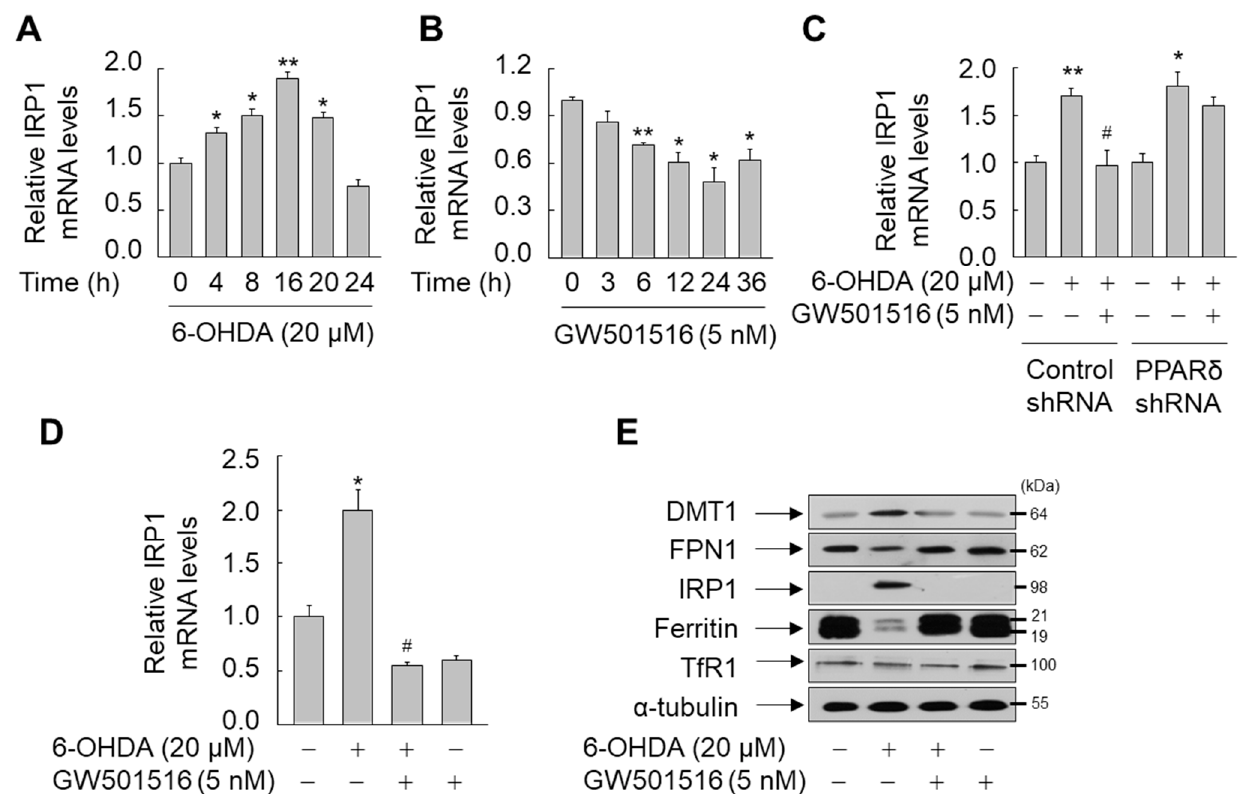
Figure 6. GW501516 PPAR δ activation suppresses 6-OHDA-induced expression of IRP1 in SH-SY5Y cells. ( A , B ) Cells were treated with 6-OHDA ( A ) or GW501516 ( B ) for the indicated durations. ( C ) Cells stably expressing shRNA targeting scrambled sequences or PPAR δ were pretreated with DMSO or GW501516 for 8 h and subsequently incubated in the presence or absence of 6-ODHA for 16 h. ( D , E ) Cells pretreated with DMSO or GW501516 for 8 h were incubated with or without 6-ODHA for 16 h. Total RNA and protein were extracted, and levels of mRNA and protein were analyzed by real-time PCR ( A – D ) and Western blot ( E ). The immunoblots are separate from those shown in Figure 4C,F. RPS18 and α -tubulin were used as internal controls for real-time PCR and Western blot, respectively. Results are expressed as means of triplicate ± SE ( A – D ). * p < 0.05, ** p < 0.01 relative to untreated group; # p < 0.05 relative to 6-OHDA-treated group.